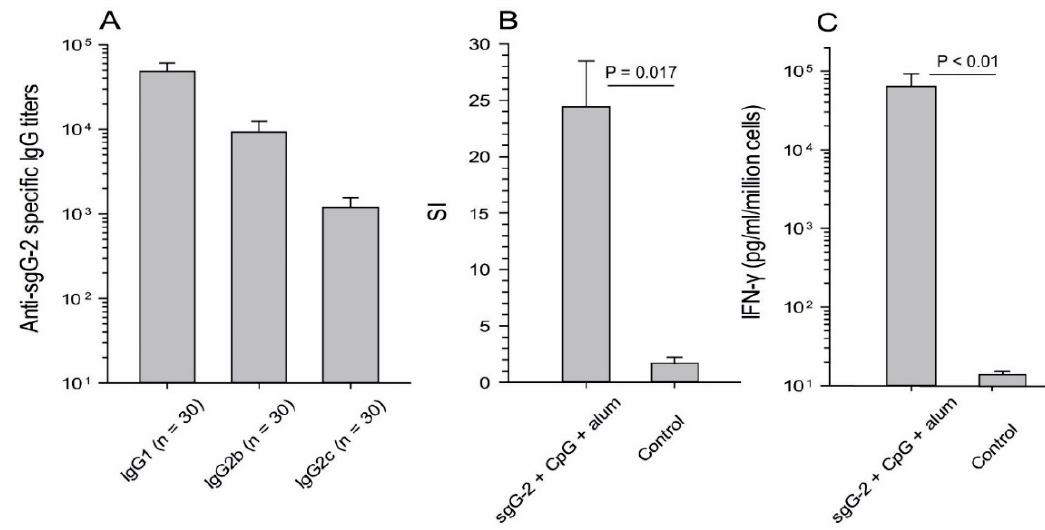
Figure 3. Antibody and CD4+ T-cell responses from sgG-2 + adjuvant i.m. immunized mice. ( A ) Serum was subjected to an anti-sgG-2 IgG subclass specific enzyme-linked immunosorbent assay (ELISA); ( B ) Enriched CD4+ T cells from sgG-2 + adjuvant i.m. immunized mice and PBS vaccinated control